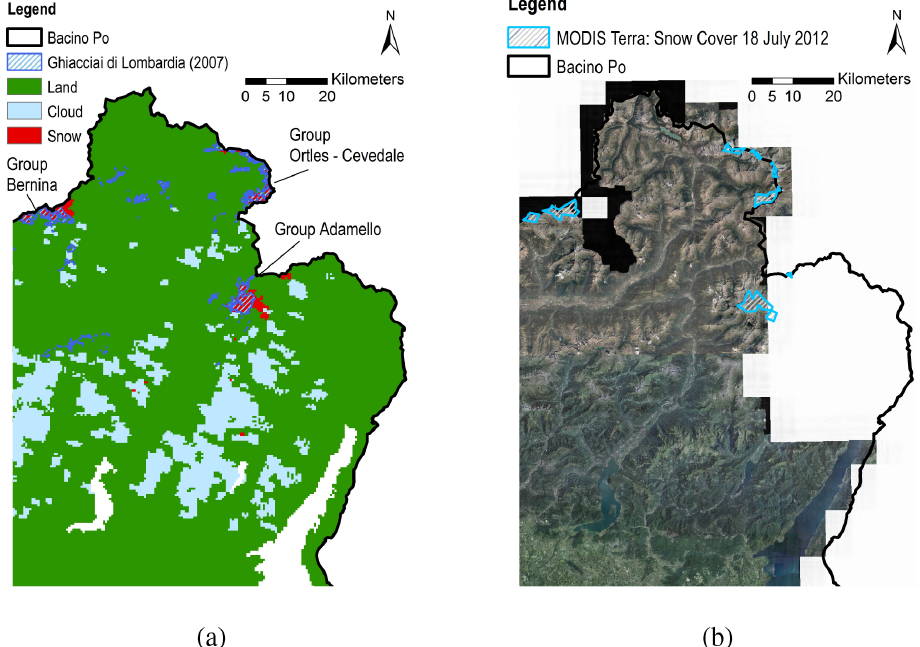
Figure 4. (a) Comparison between the digital map of Lombardy’s glaciers (sketched in blue) and the snow distribution (red) from MYD10A1 at the end of June 2005 (source Regione Lombardia https://www.dati.lombardia.it/Territorio/Ghiacciai-e-Nevai/ximi-y8y4). (b) Snow poly- gon derived from MOD10A1 of 18 July 2012 overlapped on the orthophoto AGEA 2012 of Lombardia. The latter is a composite image from air flights operated at the beginning of September 2012 (source Regione Lombardia